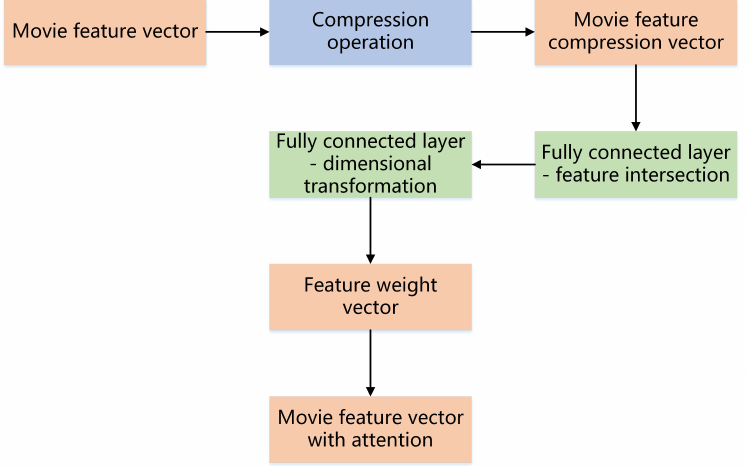
Figure 6. Movie network feature attention layer processing flow